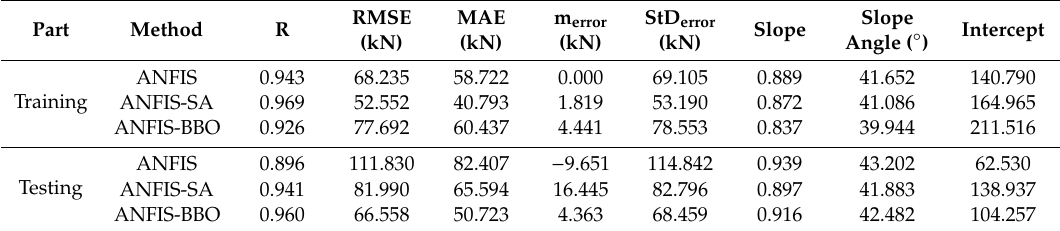
Figure 6. Graphs of N u in function of sample index for ( a ) the training part and ( b ) the testing part.